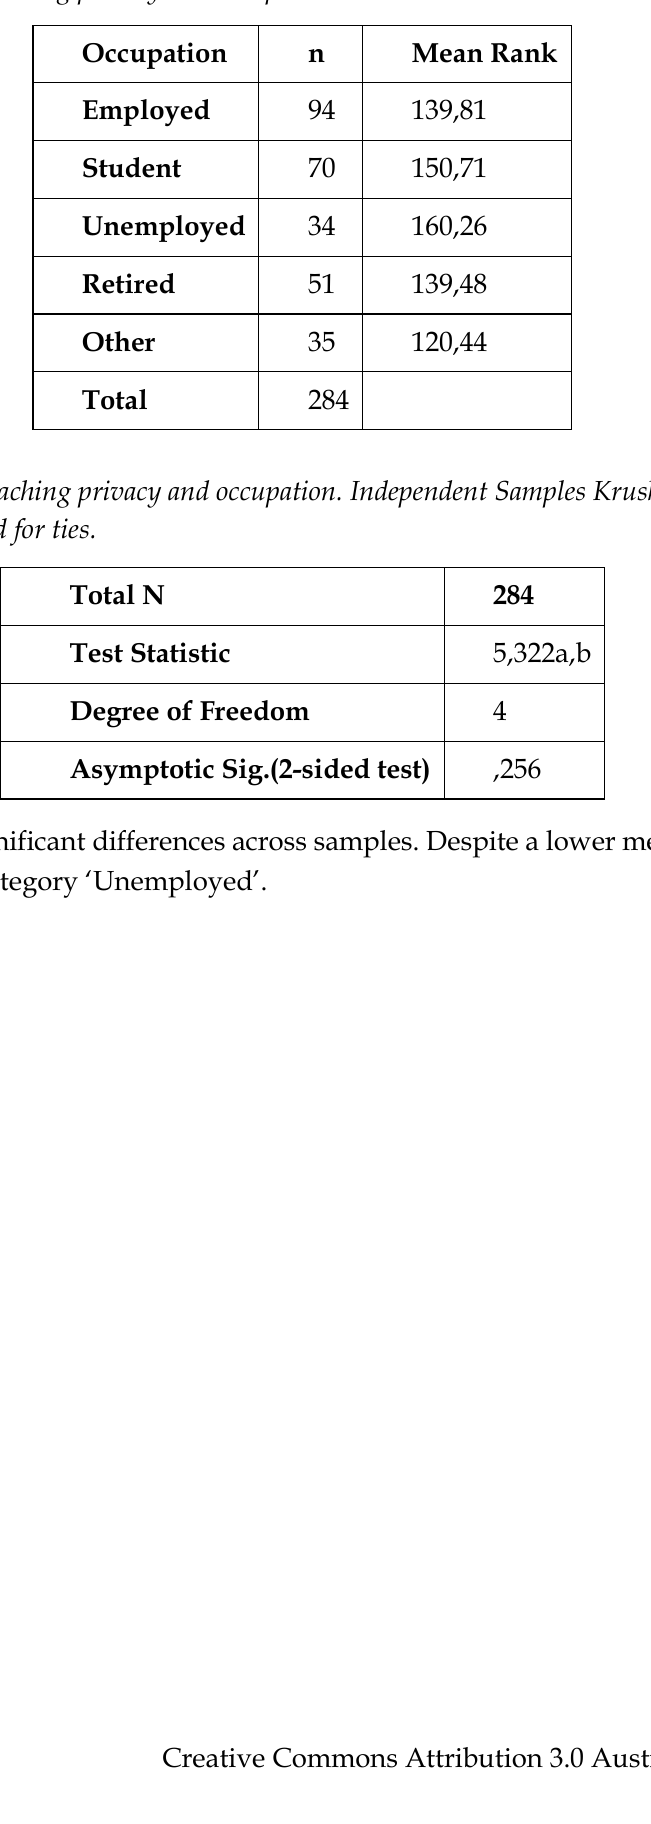
Table 8. Concern about breaching privacy and occupation. Kruskal-Wallis mean rank.